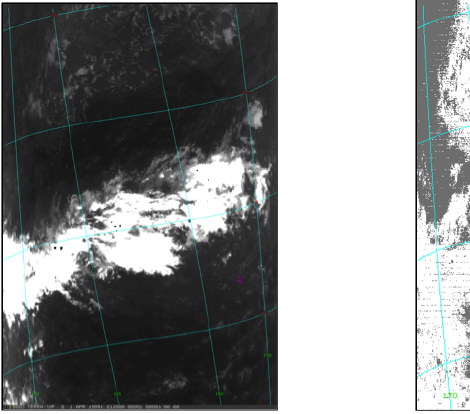
Figure 12. Terra MODIS band 31 (11 µ m) imagery ( left ) on 1 April 2015, Cloud Mask ice cloud test result before crosstalk correction ( center ) and after crosstalk correction ( right ). Ice particles are indicated by cold (bright) scenes in the 11 µ m imagery. Before crosstalk correction, the ice cloud test falsely detects ice clouds over the large majority of the granule, including over water clouds and clear scenes. After crosstalk correction, ice clouds are only detected in the region of the high cold clouds in the 11 µ m